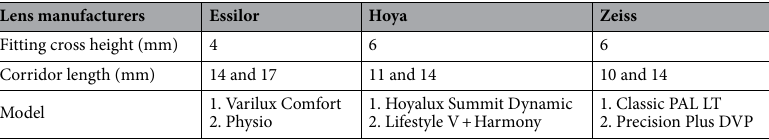
Table 1. Characteristics of progressive addition lenses measured.